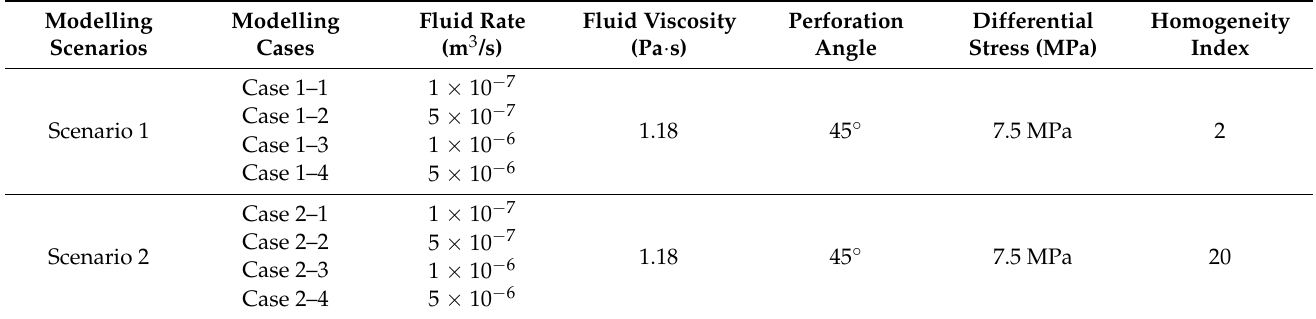
Table 6. Modelling scenarios to study the effect of fluid rate on HF re-orientation in heteroge- neous